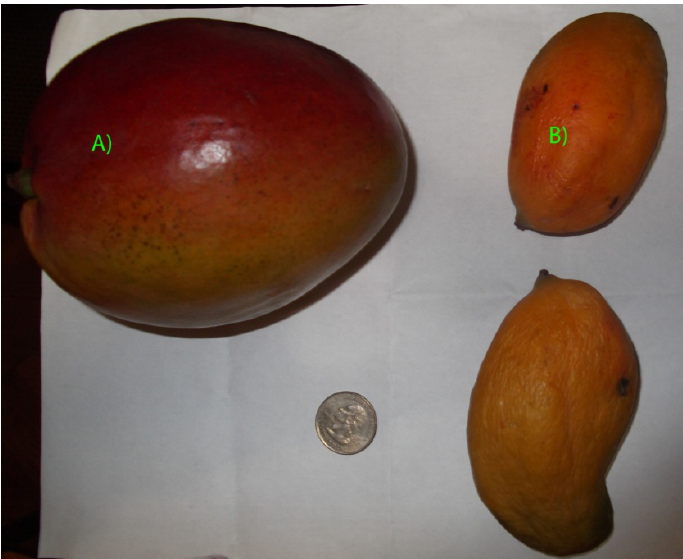
Figure 1. Photograph of ( A ) ripe Tommy Atkins Mango Fruit and ( B ) Pica Mango